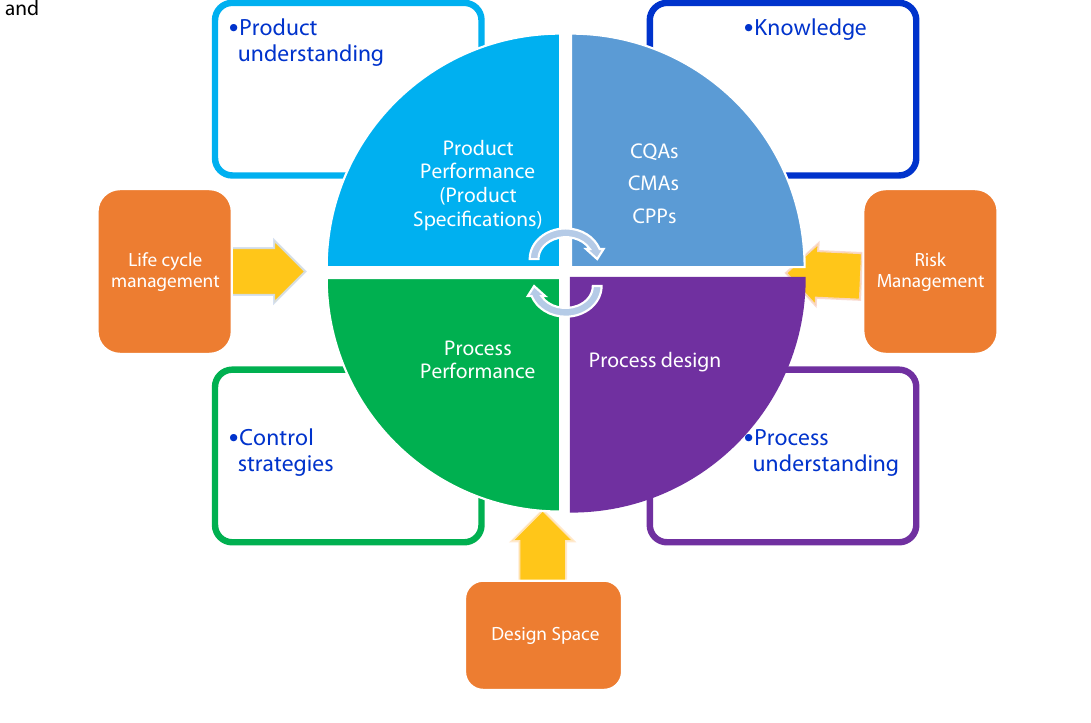
Fig. 2 QbD understanding and life cycle